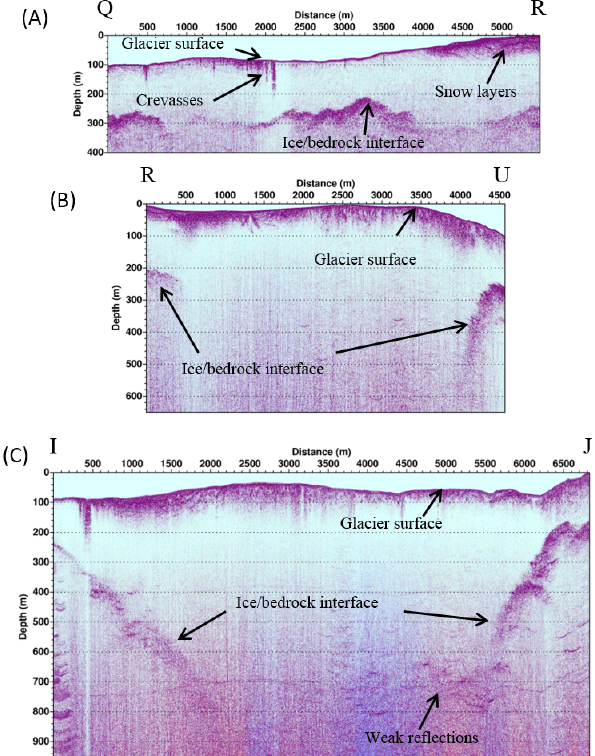
Figure 5. Ice–bedrock interface measured by GPR along profiles [QR] (A) , [RU] (B) and [IJ] (C) of Fig. 4. Snow layer horizons be- come visible on profile [QR] after a distance of 4000m when enter- ing the accumulation zone. Combined effects of depth and floating ice seriously alter the reflectors in the middle of profile [IJ] and lead to a total loss in the middle of profile